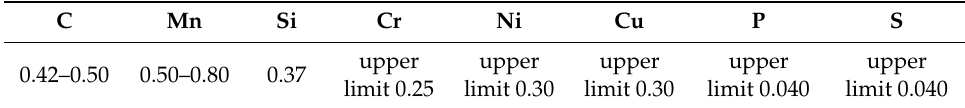
Figure 6. NJC 160 metallographic microscope ( a ) and Digi Micro 2.0 Scale microscope ( b ). Table 2. C45—chemical